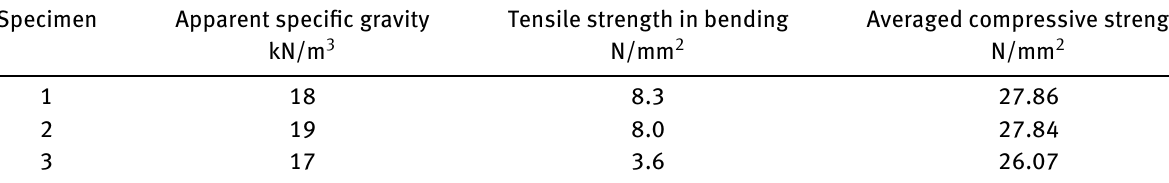
Table 3: Experimental properties of the special binding mortar Specimen